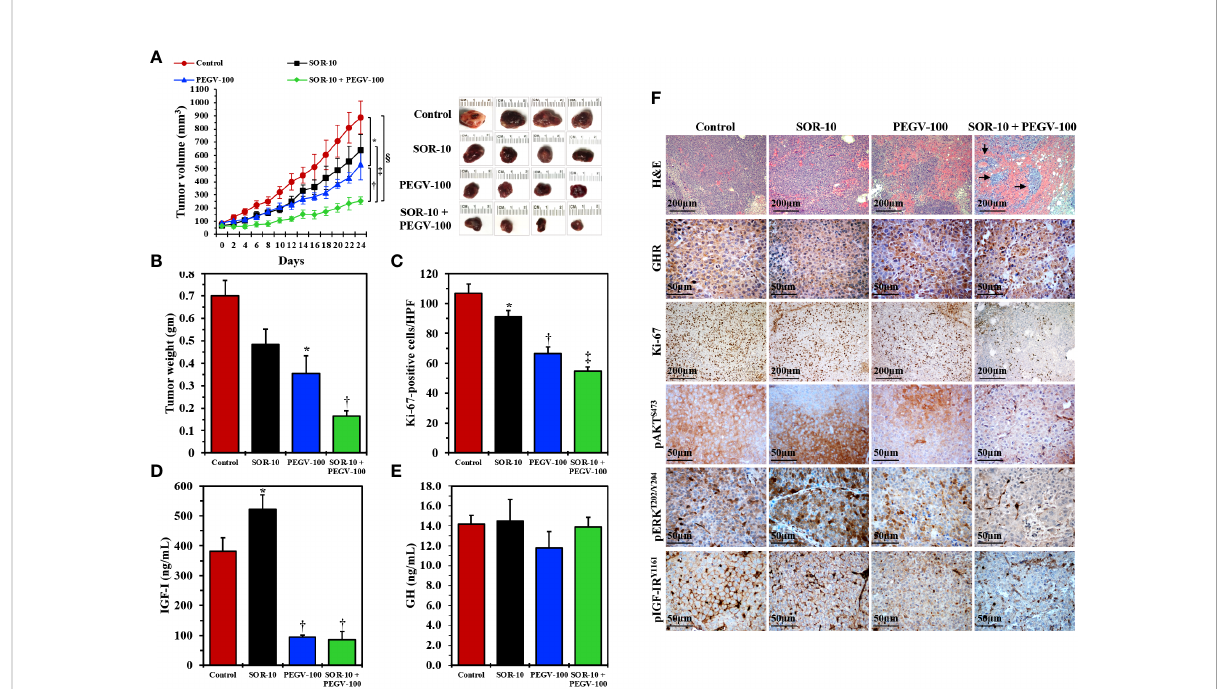
FIGURE 5 In vivo effects of antagonizing GH/GHR signaling axis using pegvisomant alone or in combination with a low dose of sorafenib in mice with parental HCC xenografts. Treating nude mice (females; control, seven mice; PEGV-100, seven mice; SOR-10, six mice; PEGV-100+SOR-10, six mice) harboring parental HepG2 HCC xenograft tumors with pegvisomant at a dose of 100 mg/kg/day (PEGV-100) signi fi cantly decreased the growth (A) Representative examples of HCC tumors from the four groups after necropsy on day 24 are shown in the right panel), weight (B) , and proliferation (C) of these tumors when compared to control mice treated with vehicle. In contrast, sorafenib alone at a dose of 10 mg/kg/day (SOR-10) did not have signi fi cant effects on tumor growth and weight and induced a very minimal decrease in cell proliferation. Of important note, the combined inhibitory effects of PEGV-100 and SOR-10 on HCC tumor growth and weight were superior to the effects of either of these two drugs alone ( A *P = 0.02 vs. control mice; † P = 0.02 vs. PEGV-100; † P < 0.01 vs. SOR-10; § P = 0.0002 vs. control, B *P < 0.01 vs. control; † P < 0.05 vs. PEGV-100; P < 0.001 vs. SOR-10; P < 0.0001 vs. control, C *P = 0.04 vs. control; † P < 0.0001 vs. control and P < 0.001 vs. SOR-10; ‡ P < 0.0001 vs. control and SOR-10 and P = 0.02 vs. PEGV-100). Notably, the combined suppression became statistically signi fi cant only 8